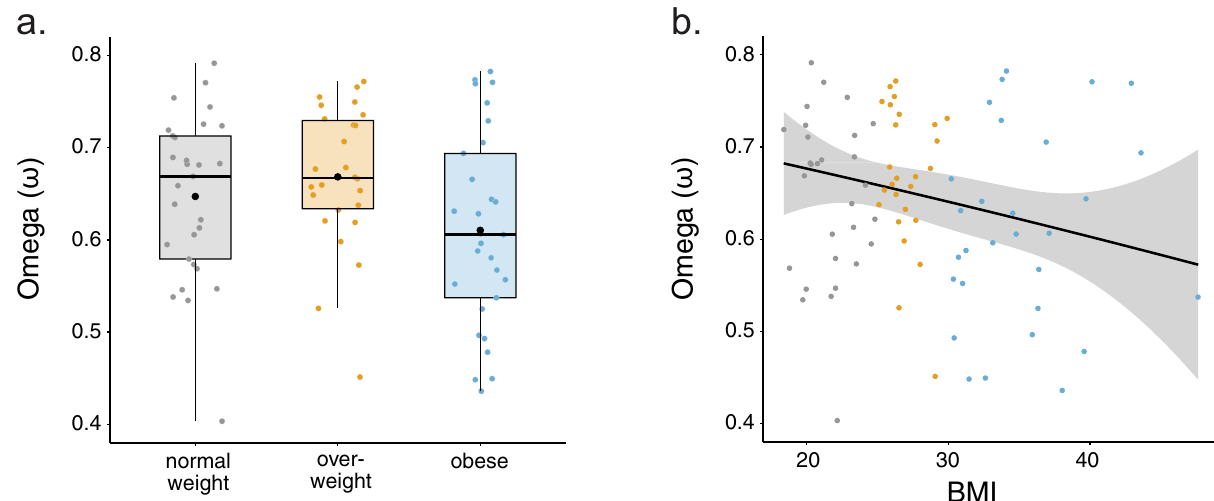
Figure 3. Relative reliance on model-based and model-free control (omega). ( a ) On the group level, omega was significantly lower for obese relative to normal-weight and overweight participants. The box plot reflects the median, interquartile range, and mean value (black dot) for each weight group. ( b ) On the continuous level, omega was negatively related to BMI, with no additional significant quadratic relationship. The scatter plot shows the model fit (black line) and confidence interval (shaded) of the regression model. Individual data points are color-coded based on weight group for illustrative purposes.